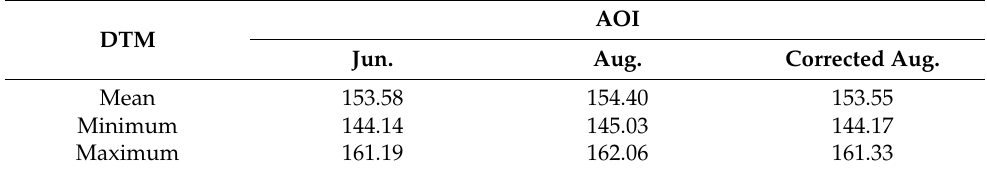
Table 8. Characterisation of DTMs by elevation values (m) obtained for the area of interest (AOI).